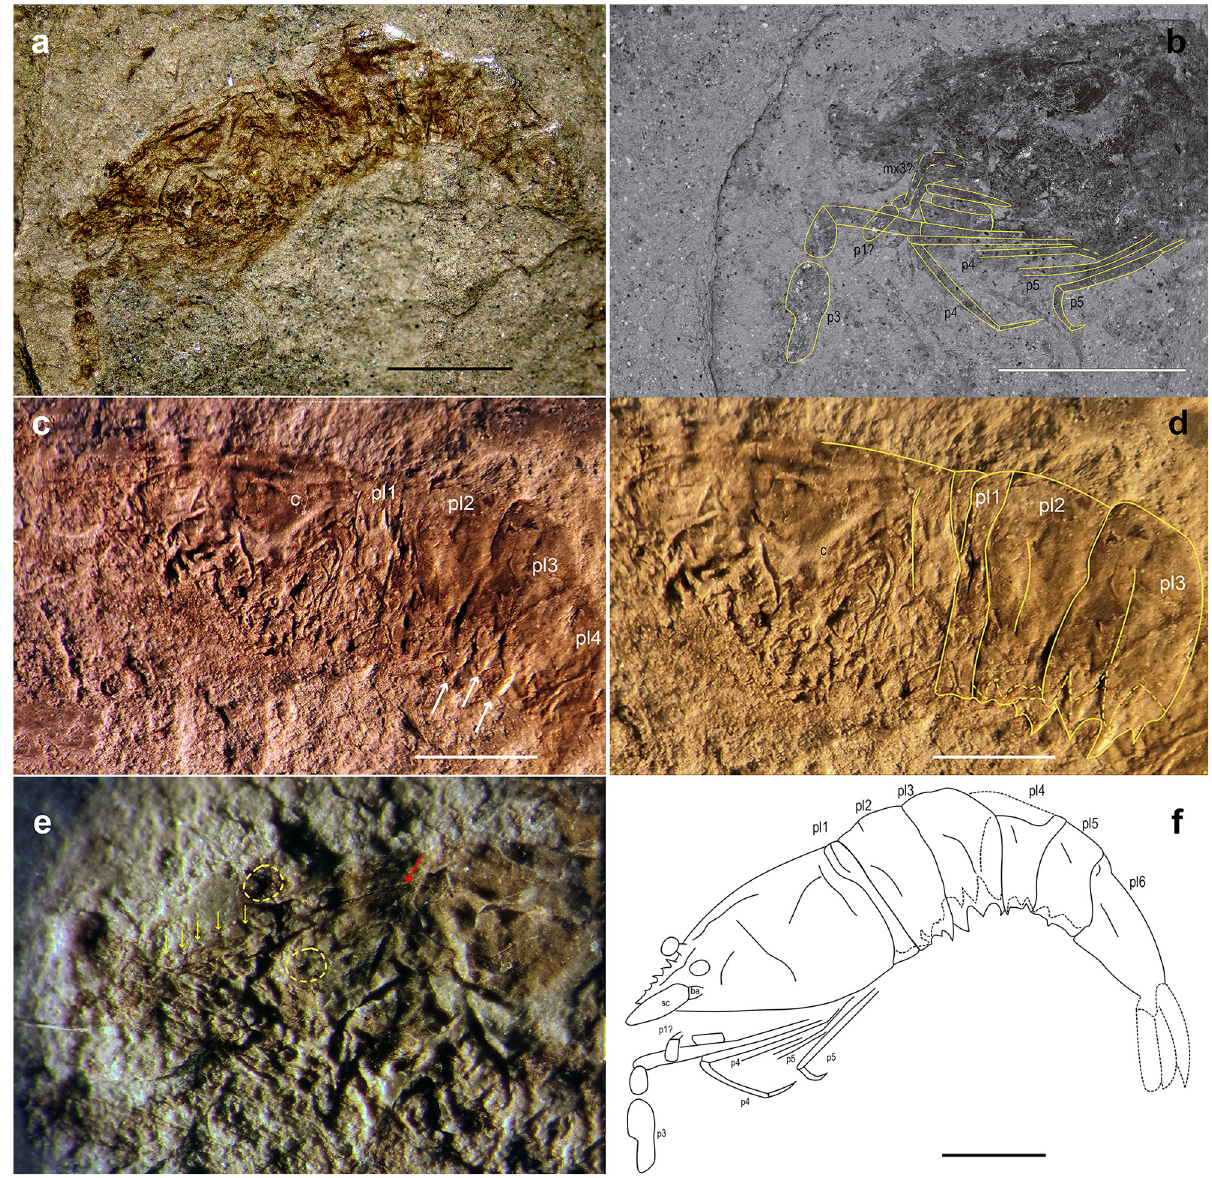
Fig 3. Dubiostenopus parvus n. gen. n. sp. Dubiostenopus parvus gen. nov. sp. nov. (MPSC 2542) from the Romualdo Formation, Cretaceous (Aptian/ Albian), Araripe Basin: (a) lateral view of the holotype; (b) SEM image of the holotype, lateral view, detail of pereiopods; (c) detail of pleomeres 1–4; white arrows show the third pleura strong ventral spines; (d) detail of pleomere 1–3; dotted lines represent the right pleural margins; (e) detail of anterior region; dotted lines represent the eyes position; yellow arrows indicate the dorsal rostral spines; red arrow indicates the rostrum posterior margin; (f) line drawing of the holotype; dotted lines represent pl4 dorsal region not preserved and the right pleural margins. Scale bars: 2 mm. Specimen dry, uncoated. Photos: (a, b) A.P. Pinheiro; (c, e, f) D. Lima. Line drawing by D. Lima.